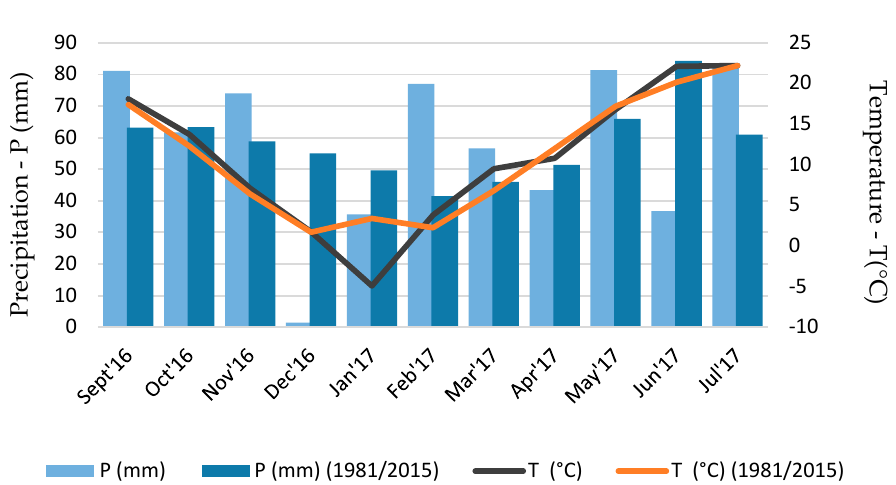
Figure 2. Average temperature and precipitation in winter wheat vegetation (September 2016–July 2017) and long-term average (1981/2015) for the Gat experimental site.